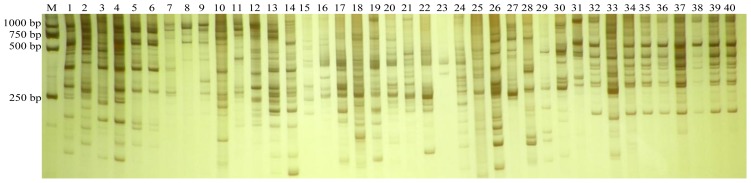
A typical ISSR profile of the 40 accessions of cultivated bromeliads, produced by U848. M indicates DNA marker ladder. The accession number refers to Table 1.